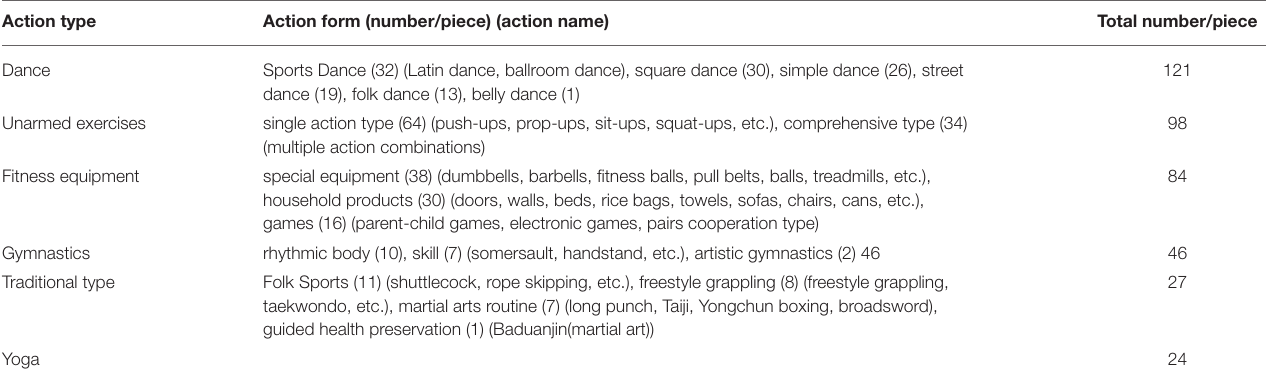
TABLE 5 | Fitness preference statistics of the disseminators of short fitness videos on TikTok. Action